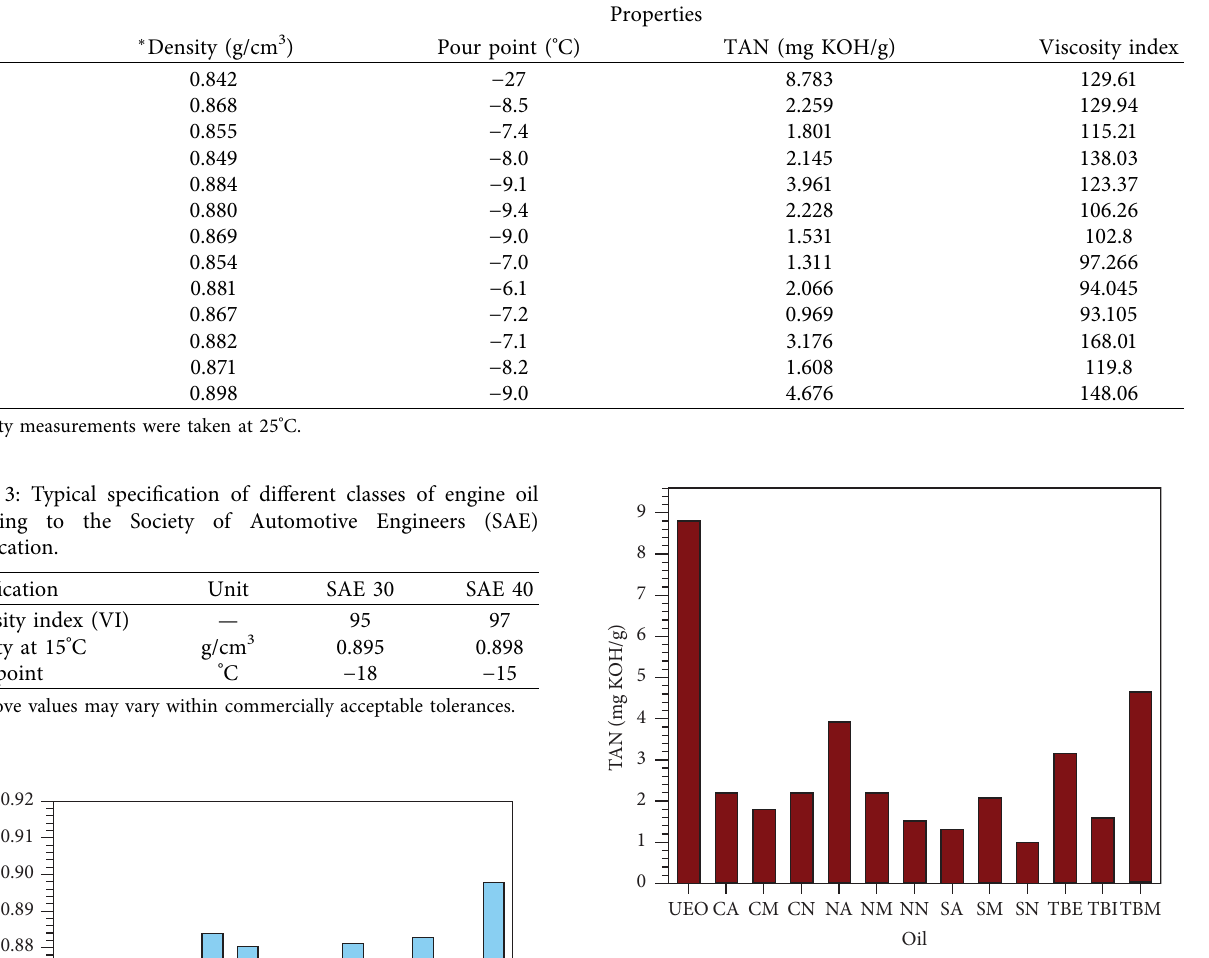
Figure 2: Total acid number of the used engine oil and re-refned oils compared to SAE 30 oil